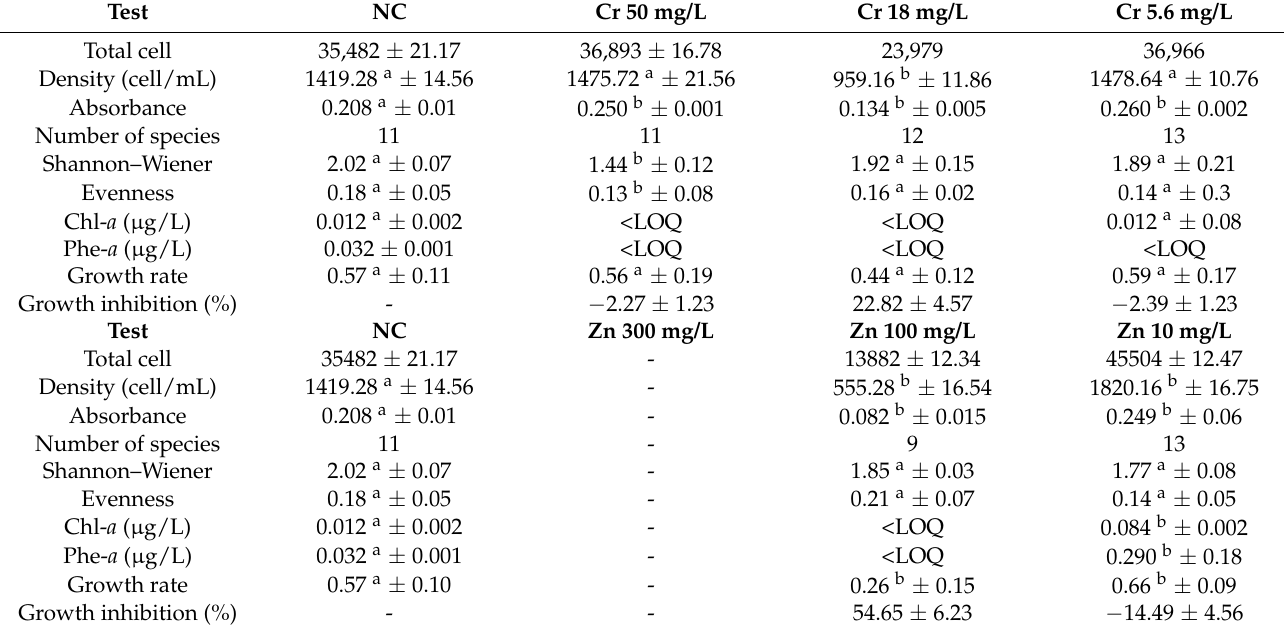
Table 2. Results of ecotoxicological assay of potassium dichromate-K 2 Cr 2 O 7 (Cr; a) and zinc oxide nanoparticles-ZnO NPs (Zn; b) on brackish water phytoplankton community. NC denotes negative control. Lowercase letters ( a , b ) denote differences revealed by Conover–Iman post hoc or Mann–Whitney tests. Phe- a = pheophytin-a; Chl- a = chlorophyll- a